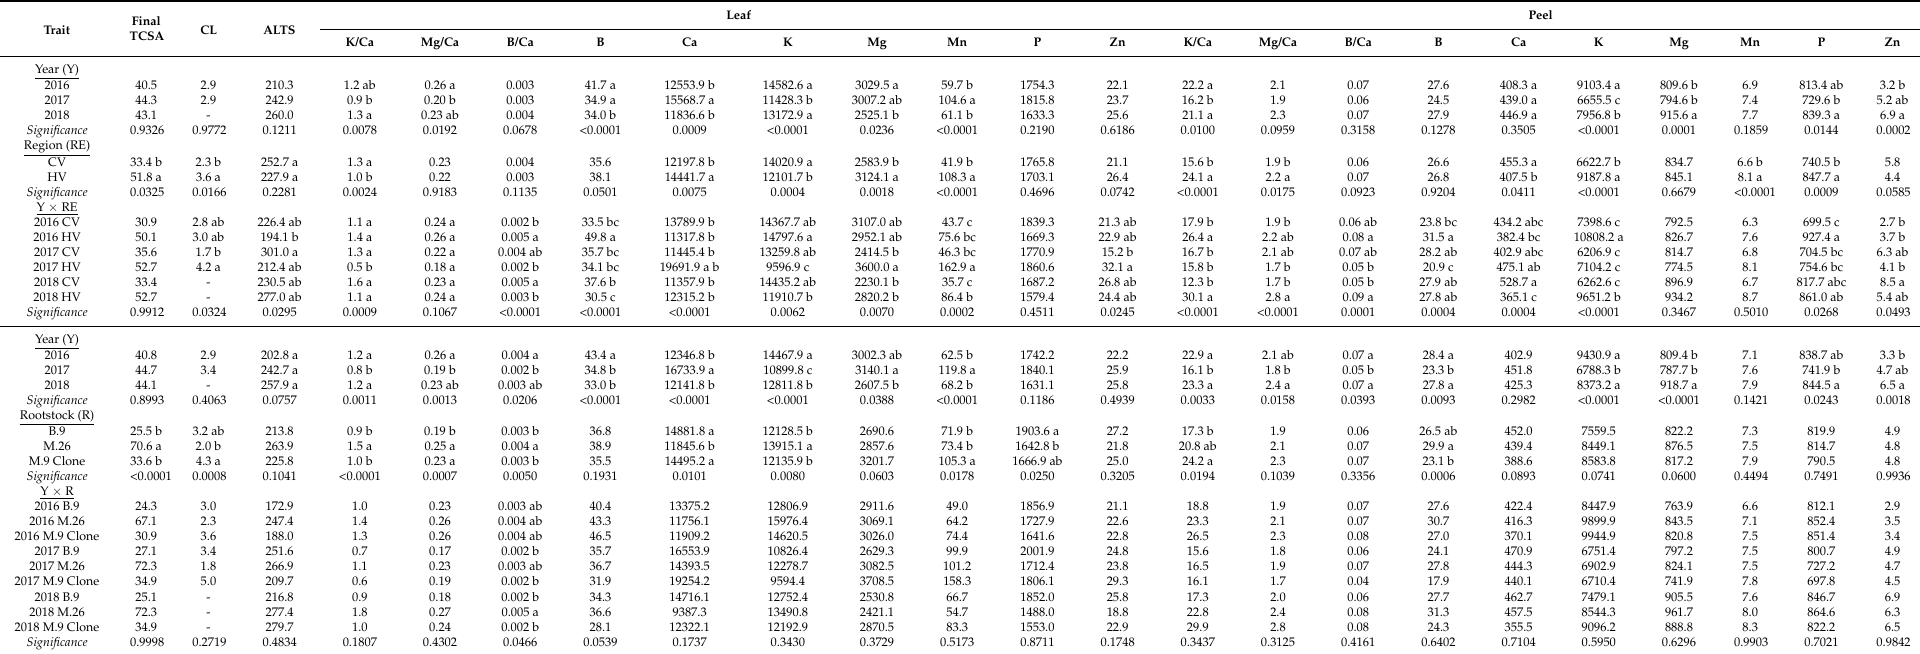
Table 4. Horticultural measurements of ‘Honeycrisp’ for year, region, rootstock, and their